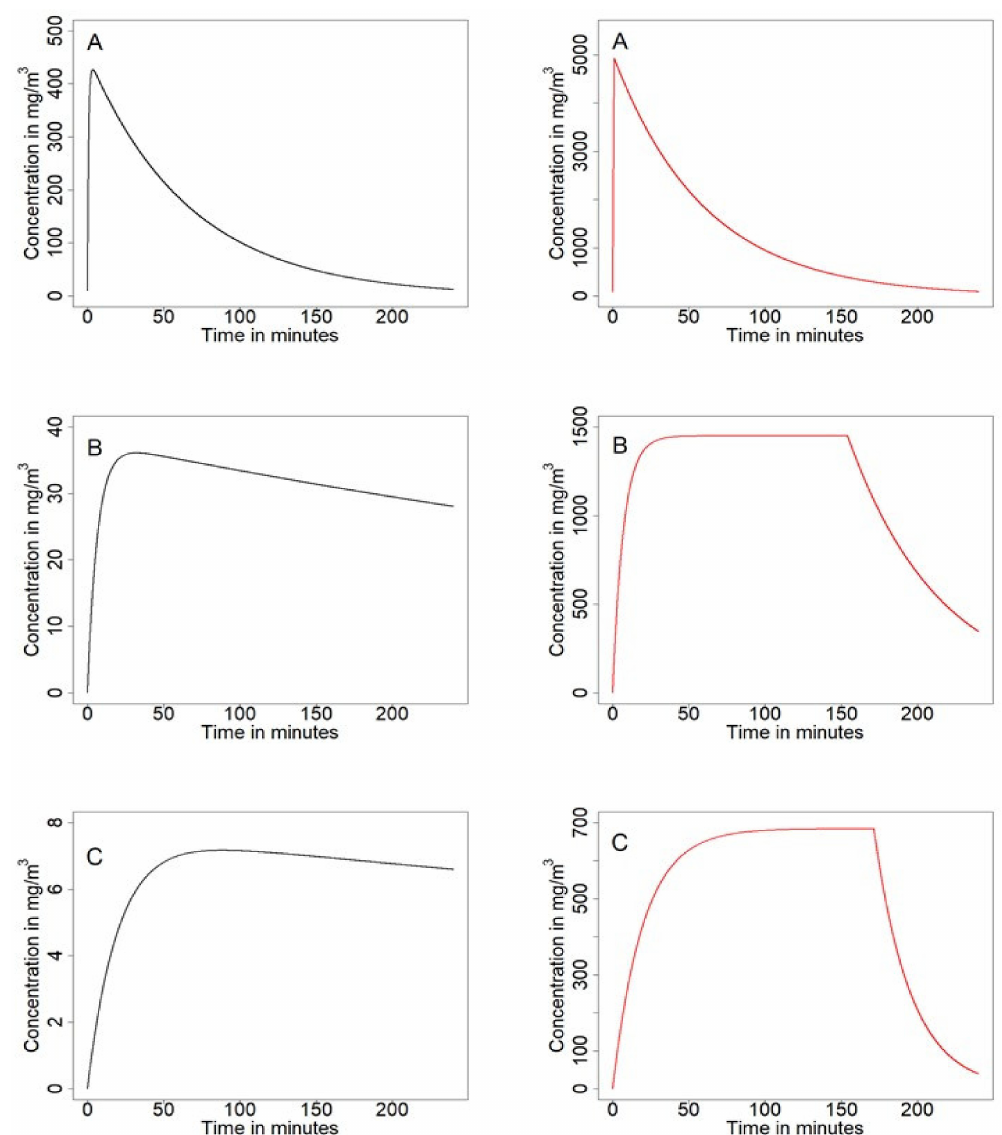
Figure 2. Substance room concentration for small substance concentrations (left) and pure substance (right) for ( A ) the quick release regime; ( B ) the near equilibrium regime; and ( C ) the ventilation driven regime. The according parameters are given in the Supplementary Materials Part